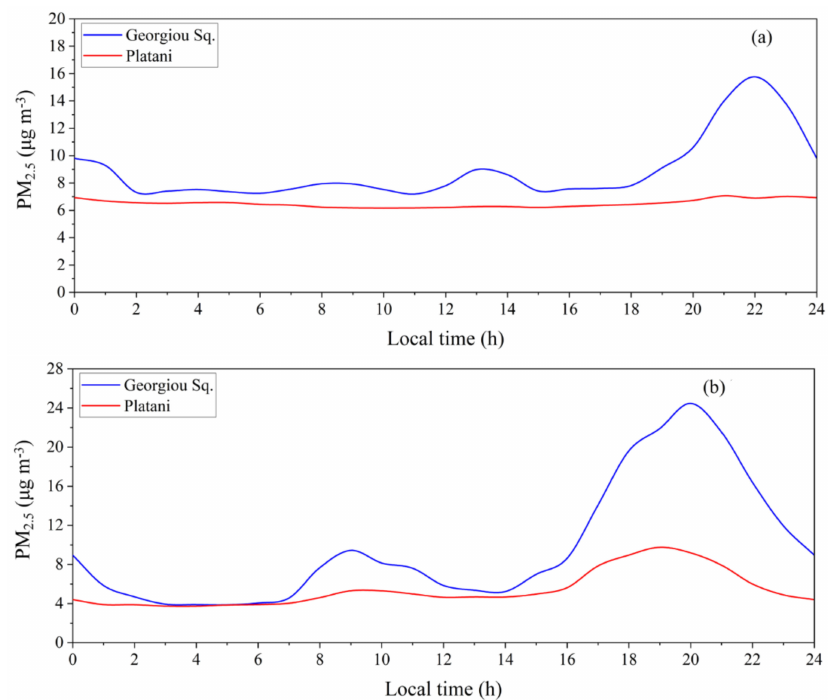
Figure 10. Predicted average diurnal profile of PM 2.5 at two sites in Patras during: ( a ) July and ( b ) December 2021. Different scales are used.